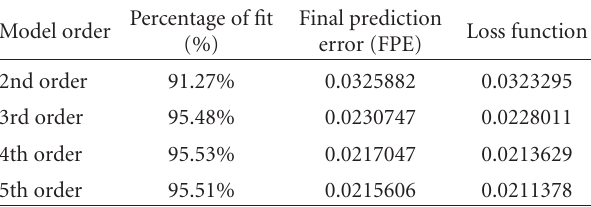
Table 1: System identification